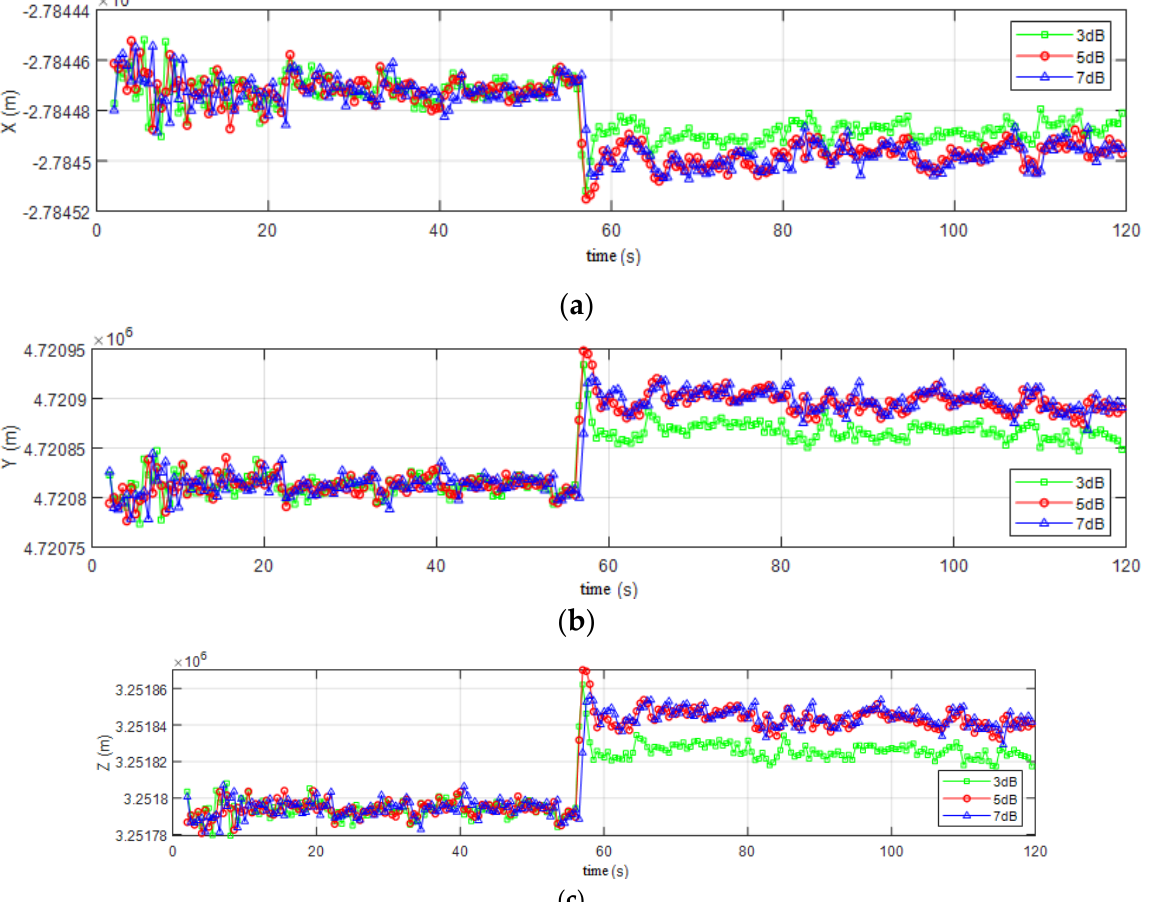
in Y direction; ( c ) Position in Z direction.